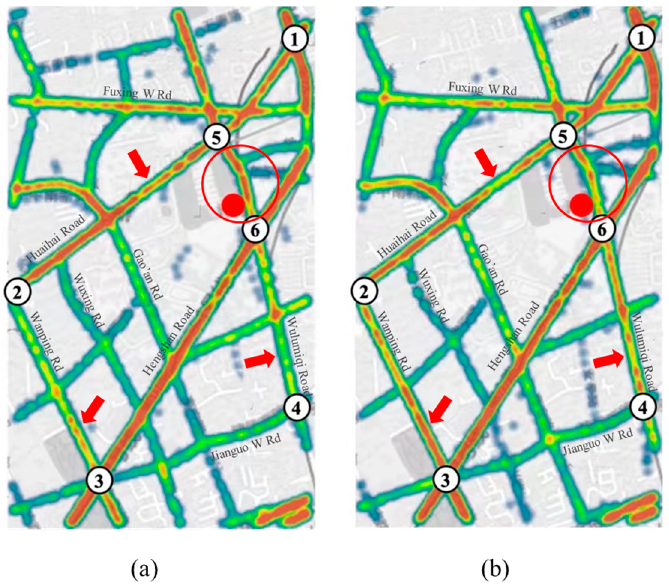
Figure 6. Heat map of regional road network traffic flow assignment at 15:30~15:45 on 2 November 2020: ( a ) Road network; ( b ) Forecast results.